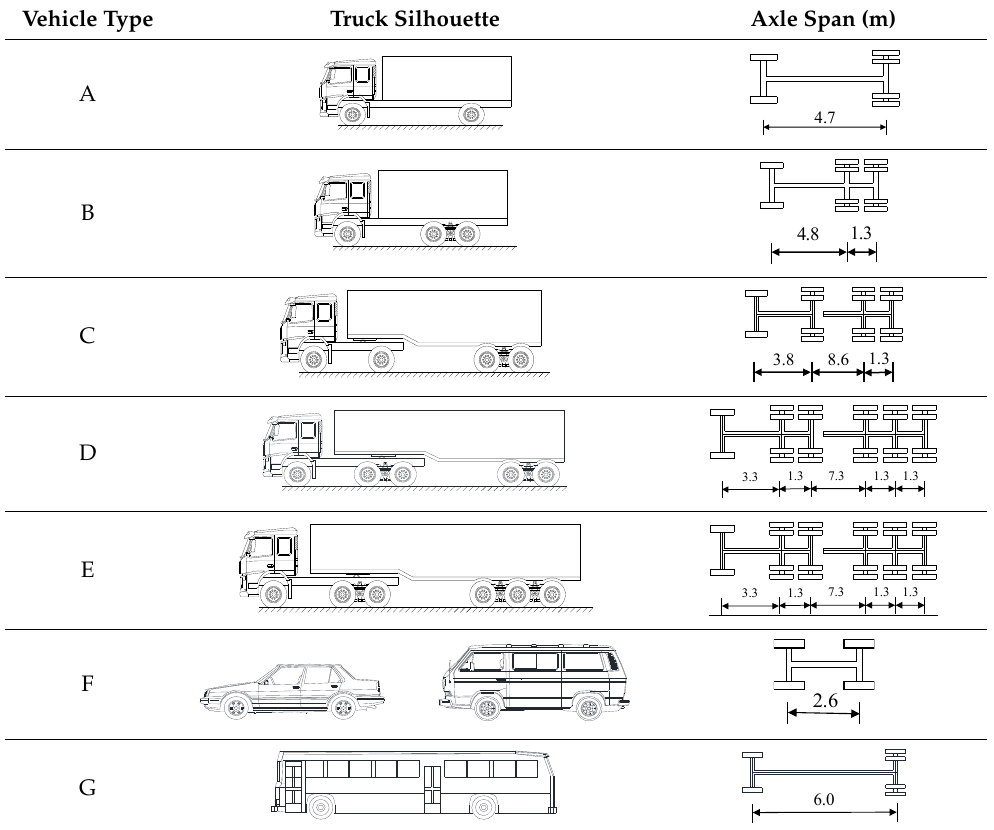
Table 2. Typical vehicle types of the investigated cable-stayed bridge.